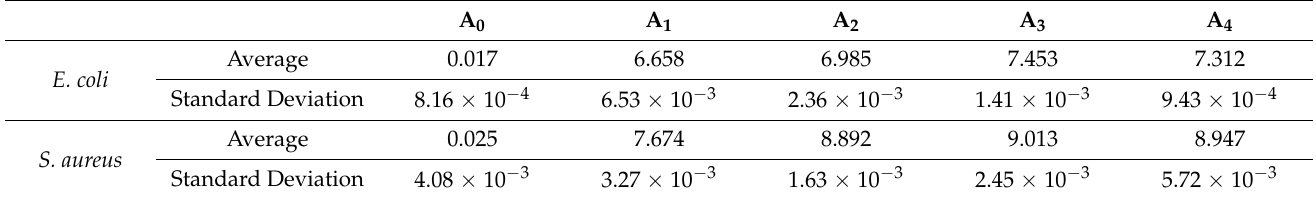
Table 2. The average and standard Deviation of Diameter of the inhibition zone D (mm) correspond- ing to Ag/UiO-66-NH 2 under conditions of varying silver doping levels.